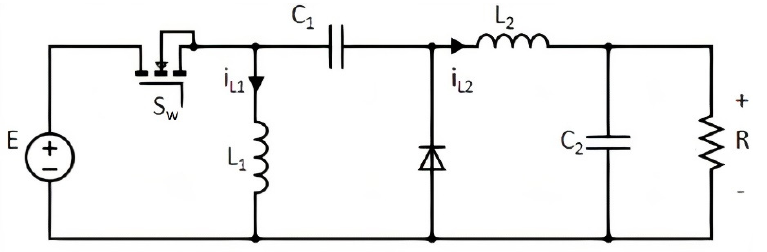
Figure 1. Circuit diagram of the POEL Converter.